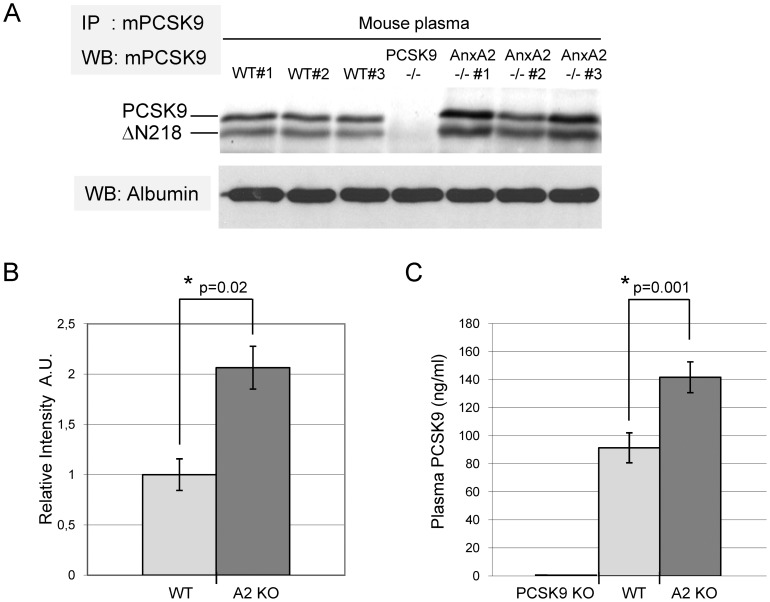
Circulating PCSK9 is increased in AnxA2−/− mice.(A) PCSK9 in plasma samples from wild-type (WT) and AnxA2
−/− mice was immunoprecipitated (IP) using an anti-mouse PCSK9 (mPCSK9) polyclonal antibody and detected by Western blotting (WB) using the same antibody as described in Materials and Methods. Mature full-length PCSK9 and its furin-cleaved form (ΔN218) are detected in WT and AnxA2
−/− mice. As control, the same method was used to immunoprecipitate PCSK9 in plasma of PCSK9
−/− mice and resulted in the absence of bands. As loading control, plasma albumin was detected by Western blotting, before immunoprecipitation of PCSK9, using a rabbit anti-mouse albumin. (B) Western blots of immunoprecipitated plasma PCSK9, as shown in (A), were quantified by scanning densitometry (n = 7 WT mice plasma samples and n = 8 AnxA2
−/− mice plasma samples). (C) Quantification of plasma PCSK9 level from WT and AnxA2
−/− mice using an ELISA assay (n = 1 Pcsk9
−/−, n = 4 WT and n = 3 AnxA2
−/− mice plasma samples). Bars and error bars represent average ± SD. P-values were obtained using a two-tailed Student's t-test.